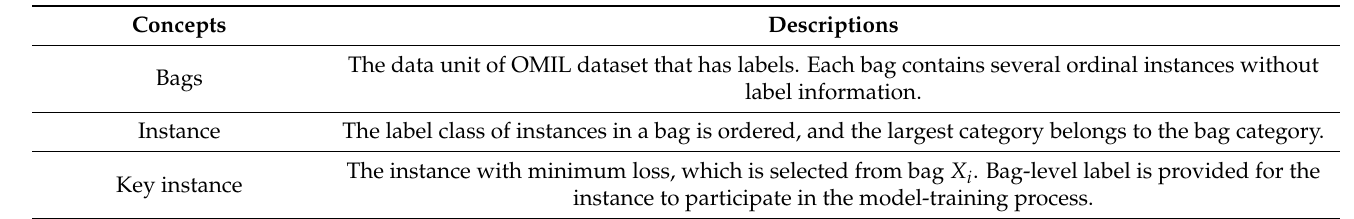
Table 1. Three relevant, important concepts of